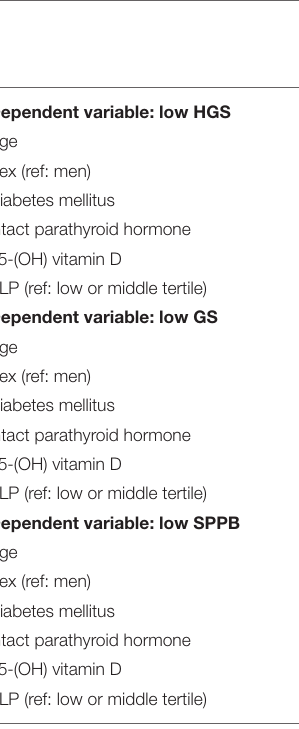
TABLE 3 | Logistic regression analysis of low HGS, GS, or SPPB according to